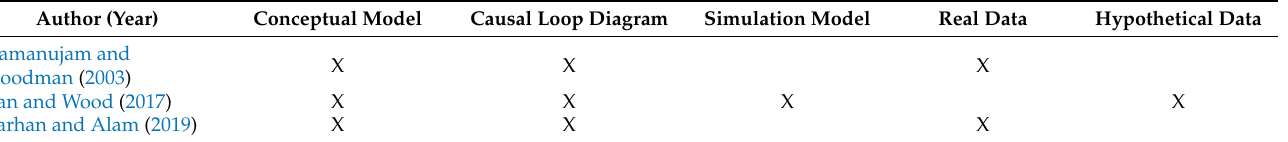
Table 5. Types of system dynamics models used in banking operational risk management